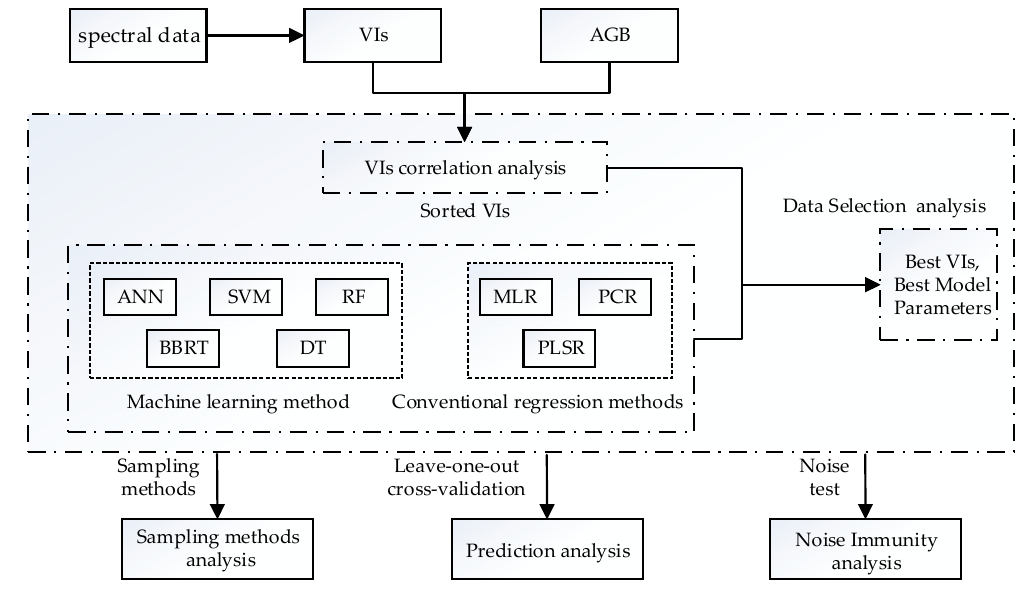
Figure 3. Flowchart showing experiment methodology. Data selection, sampling methods, noise immunity, and prediction accuracy were analyzed.